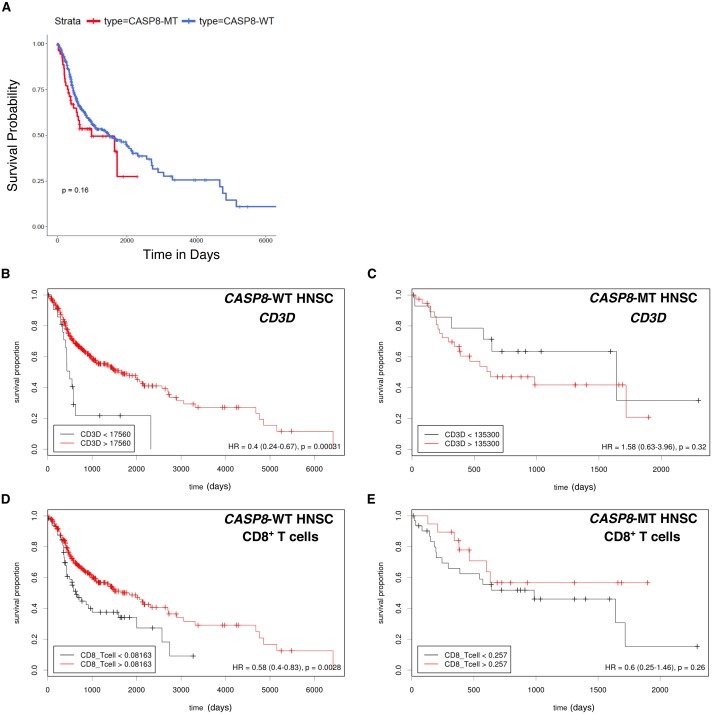
Survival analysis indicates lack of a survival advantage in CASP8-MT HNSCs in spite of their immune signature.(A) Kaplan-Meier plots showing the survival probability of patients with CASP8-WT or CASP8- MT HNSC tumors (filtered as per the schema in Fig. 1). Log-rank test was used to compare the two curves and the log-rank P-value is indicated. (B–E) Survival plots generated using the Cutoff Finder tool showing the influence of the expression levels of CD3D and the levels of CD8+ T cells on overall survival in CASP8-WT (B, D) and CASP8-MT (C, E) cases. Gene expression data was obtained from FPKM-UQ files at TCGA and immune cell infiltration data was obtained from TIMER.